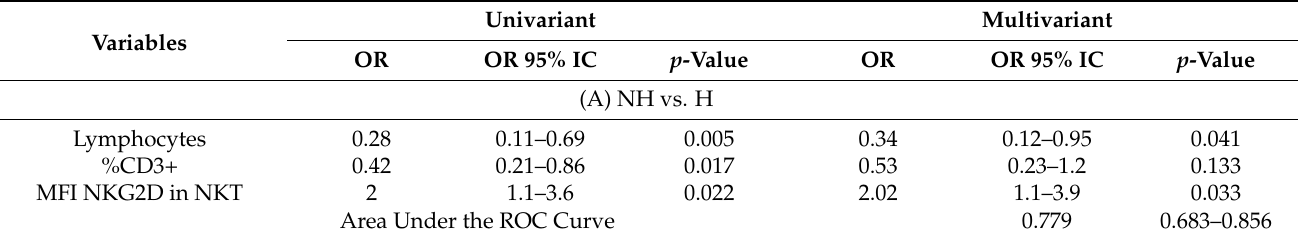
Table 3. Innate risk factors associated with disease